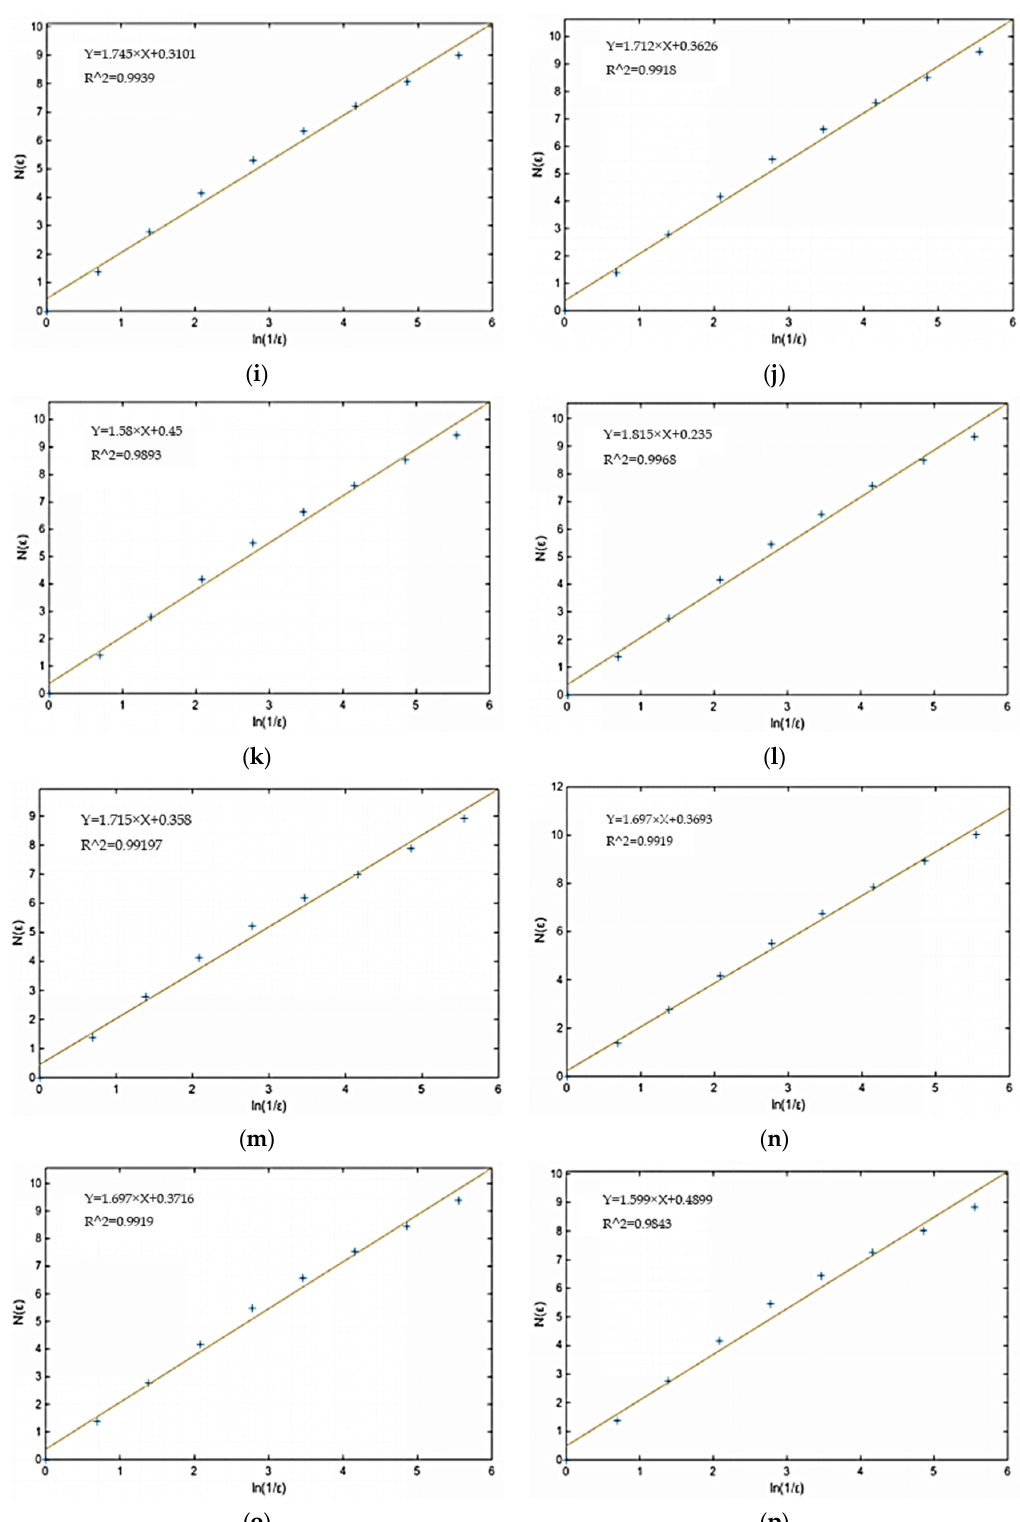
Figure A2. ( a ) Volume density 0.139 g/cm 2 ; ( b ) volume density 0.155 g/cm 2 ; ( c ) volume density 0.172 g/cm 2 ; ( d ) volume density 0.188 g/cm 2 ; ( e ) volume density 0.205 g/cm 2 ; ( f ) volume density 0.211 g/cm 2 ; ( g ) kapok fibre 30%; ( h ) kapok fibre 40%; ( I ) kapok fibre 50%; ( j ) kapok fibre 60%; ( k ) thickness of 5 mm; ( l ) thickness of 1.0 cm; ( m ) thickness of 1.5 cm; ( n ) thickness of 2.0 cm; ( o ) thickness of 2.5 cm; ( p ) thickness of 3.0